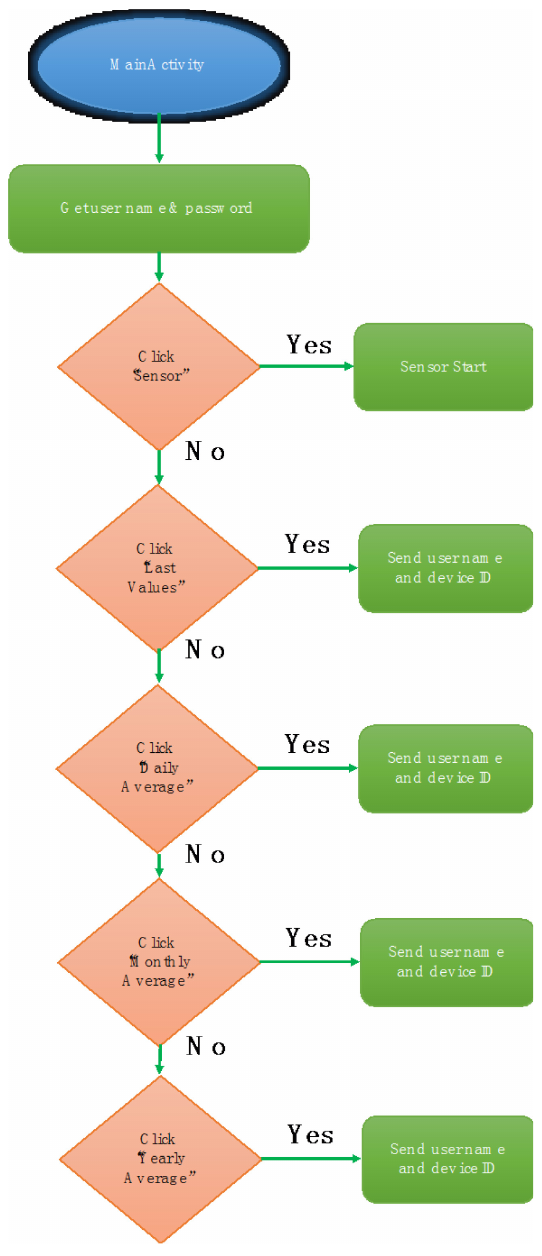
Figure 16. Main menu method flow-chart.